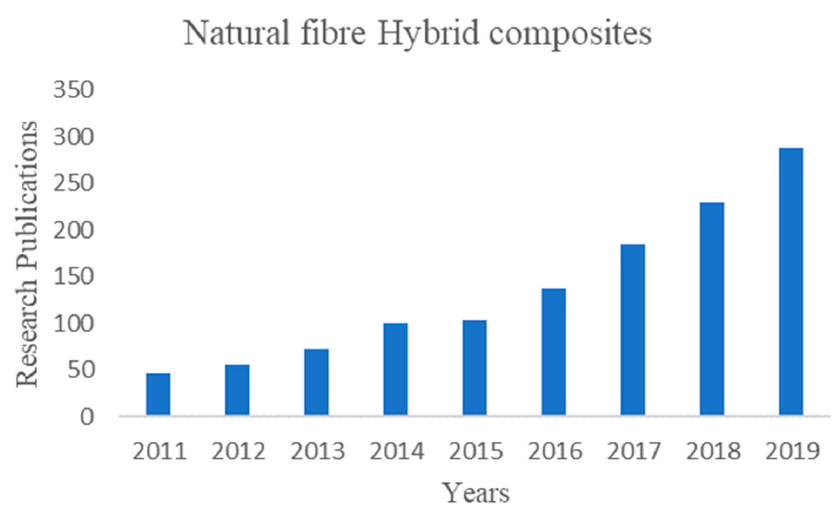
Figure 2. Recent publications on natural fiber hybrid composites.